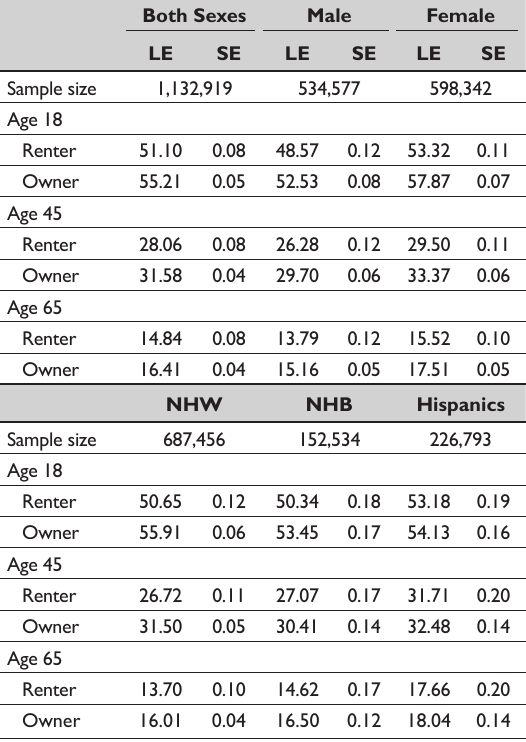
Table 4: Estimated life expectancies at selected ages at baseline by housing tenure, United States,